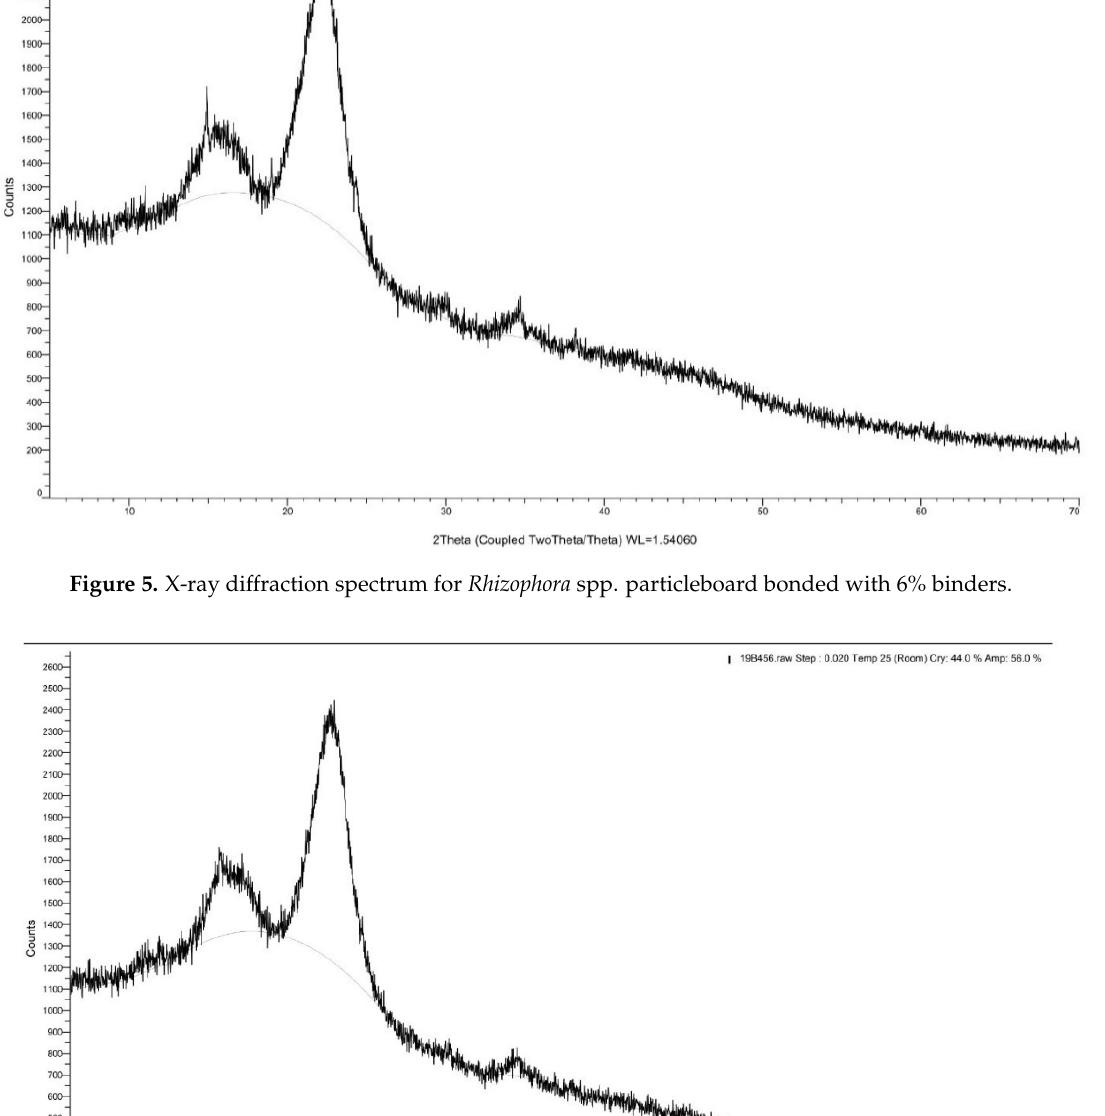
Figure 4. X-ray diffraction spectrum for Rhizophora spp. particleboard bonded with 0% binder.